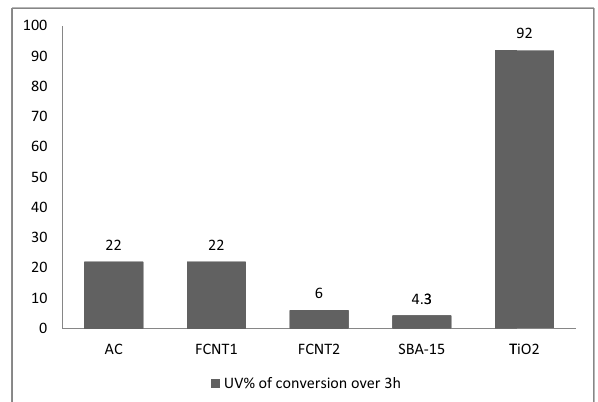
Figure 14: Nitrates conversion ( % ) analyzed by UV - Vis after 3 h of catalytic reduction using the supported catalysts: 2Pt – 1Cu/FCNT2, 2Pd – 1Sn/FCNT2, 2Pd – 1Cu/FCNT2, 1Pd – 1Cu/FCNT2, and 4Pd – 1Cu/ FCNT2 prepared by method 1 ( C NO